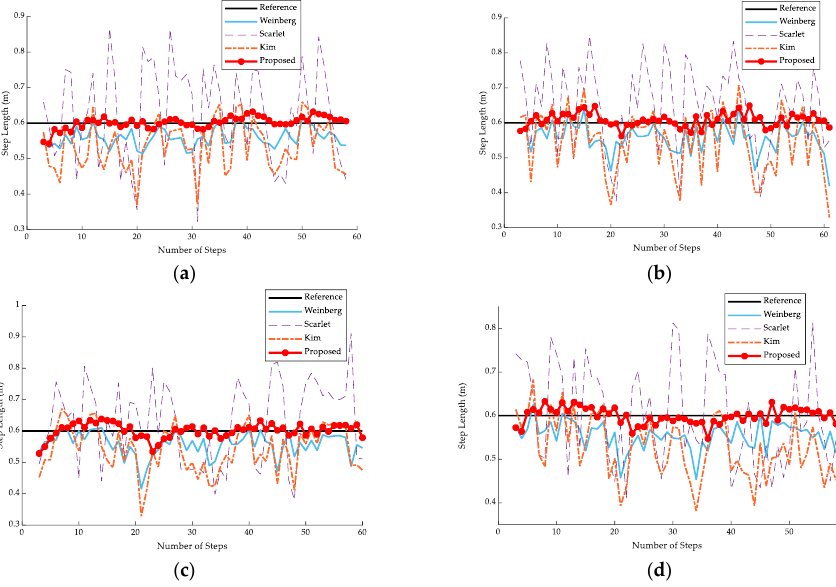
Figure 10. Step length estimation results with Honor60, VivoY85a, and two different height pedes- trians in the second scene. ( a ) Volunteer #1 with a VivoY85a cell phone. ( b ) Volunteer #2 with a VivoY85a cell phone. ( c ) Volunteer #1 with an Honor60 cell phone. ( d ) Volunteer #2 with an Honor60 cell phone.